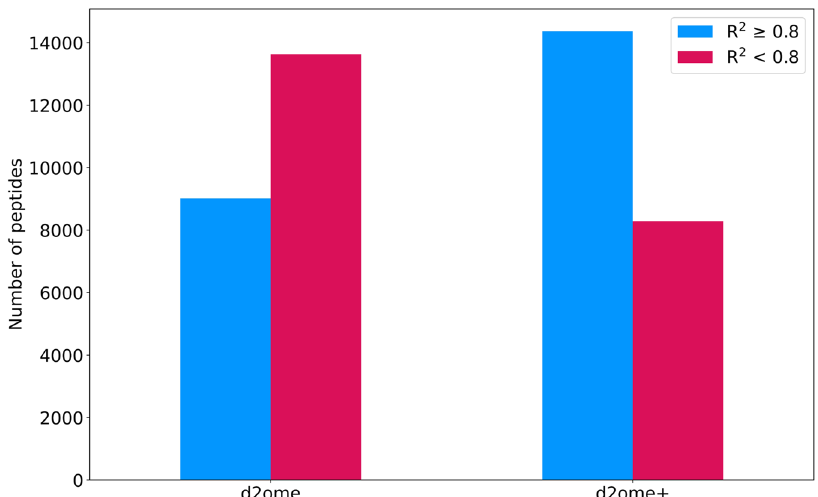
Fig. 3 The number of peptides useful for protein turnover quanti fi cation increases by 60% after processing with d2ome + (two mass isotopomer approach). The blue bars show the number of peptides for which the coef fi cient of determination (R 2 ) of the theoretical fi t to the experimental data was equal to or larger than 0.8. The red bars show the number of peptides for which R 2 is less than 0.8. From the estimations using complete isotope pro fi les (original d2ome), theoretical fi ts for 10644 distinct peptides had R 2 ≥ 0.8. The use of partial isotope pro fi les (d2ome + ) increased the corresponding number to 16708. The number of distinct peptides with R 2 < 0.8 was reduced from 14610 to